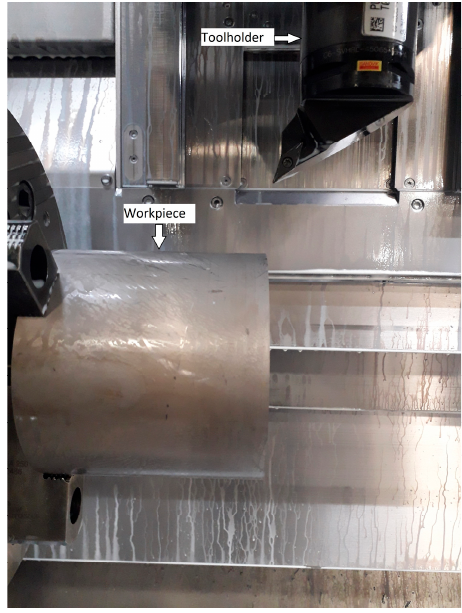
Figure 1. The tool and sample applied for the tests.